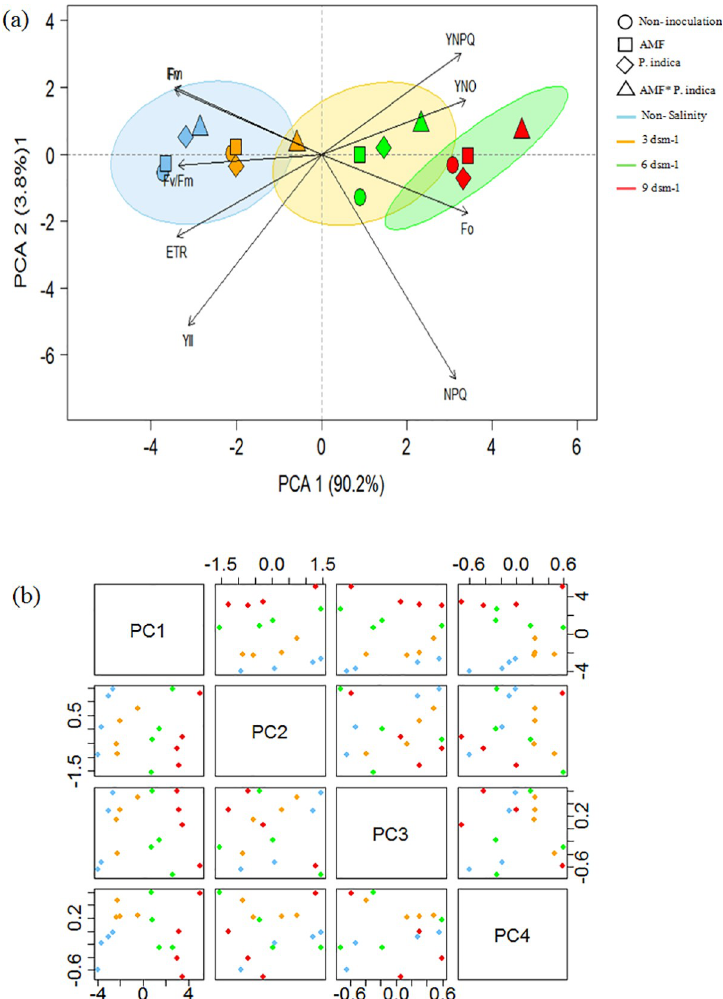
Fig 8. Principal component analysis (PCA) (a) and 2D score plot (b) of chlorophyll fluorescence parameters in peppermint leaves. The score plot for the four-salinity levels; 0, 3, 6 and 9 dsm -1 were indicated in blue, orange, green and red, respectively. Abbreviations: P . indica ; AMF–Mycorrhizae treatment; P . indica � AMF– P . indica and Mycorrhizae